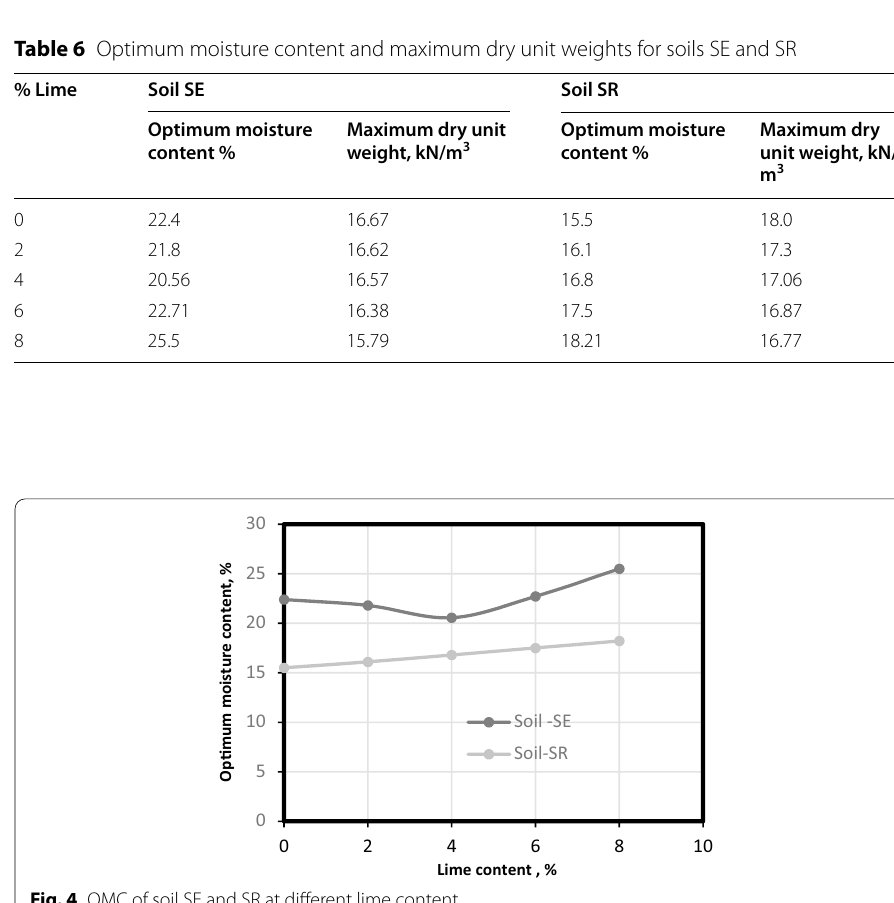
Fig. 4 OMC of soil SE and SR at different lime